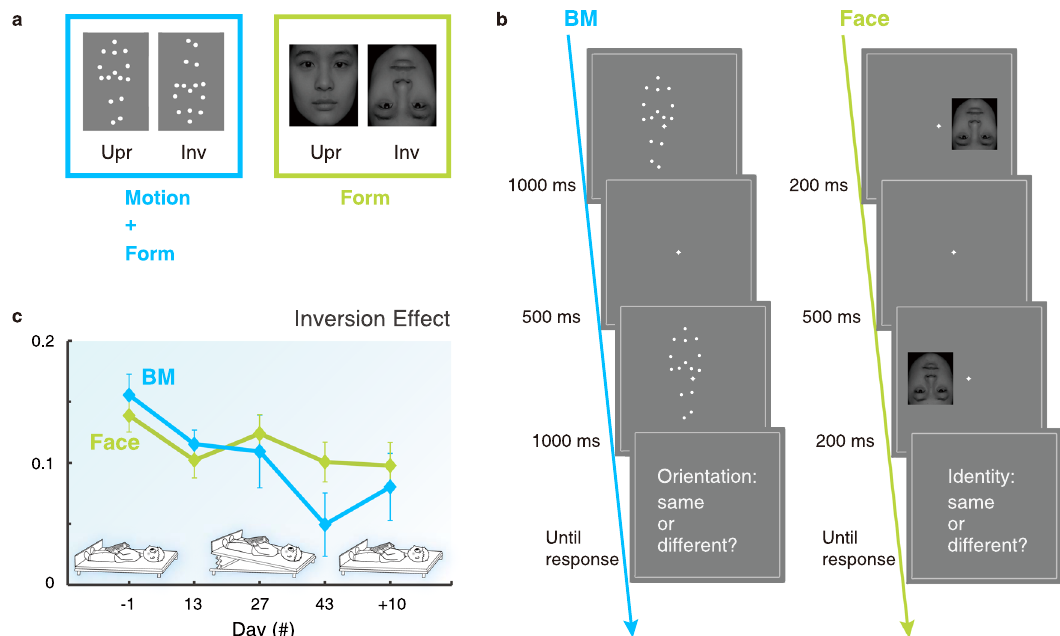
Fig. 3 Experimental design and results for the behavioral tasks of the HDTBR experiment. a We measured the BM and face inversion effects, which were respectively related to both motion and form processing and form processing alone. b Procedures of the BM and face perception tasks in which participants indicated whether two successively presented walkers/faces were the same. c The change of the perceptual inversion effect along fi ve test sessions before (day − 1), during (day 13, 27, & 43), and after the bed rest (day + 10) for the BM (blue line, n = 12) and the face (green line, n = 15) perception tasks. Error bars indicate ±1 SEM. Source data are provided as a Source Data fi